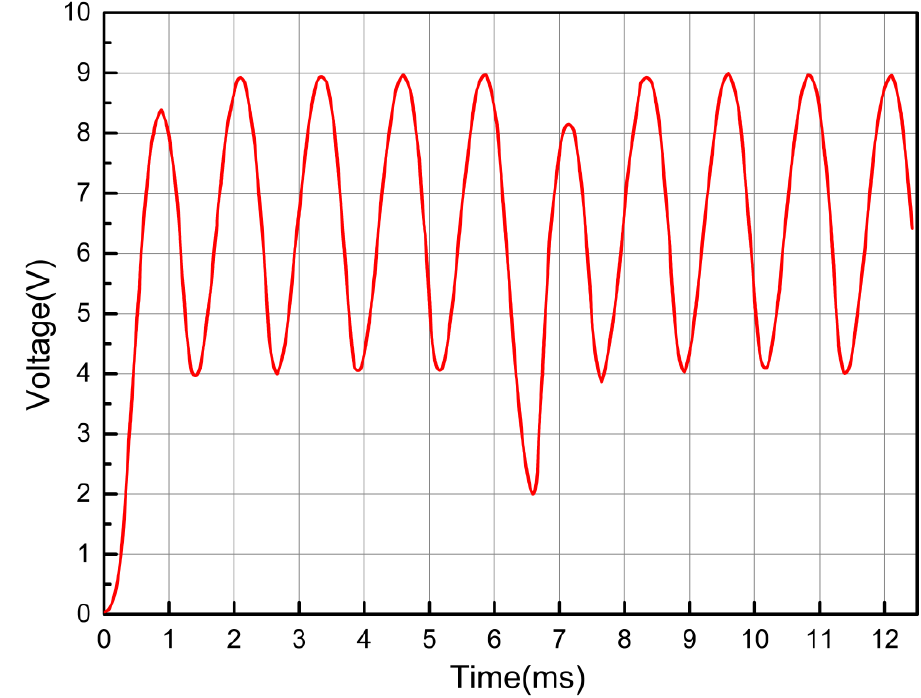
Figure 5. The voltage waveform of reference point A when value of C1 is 0.1 μF .